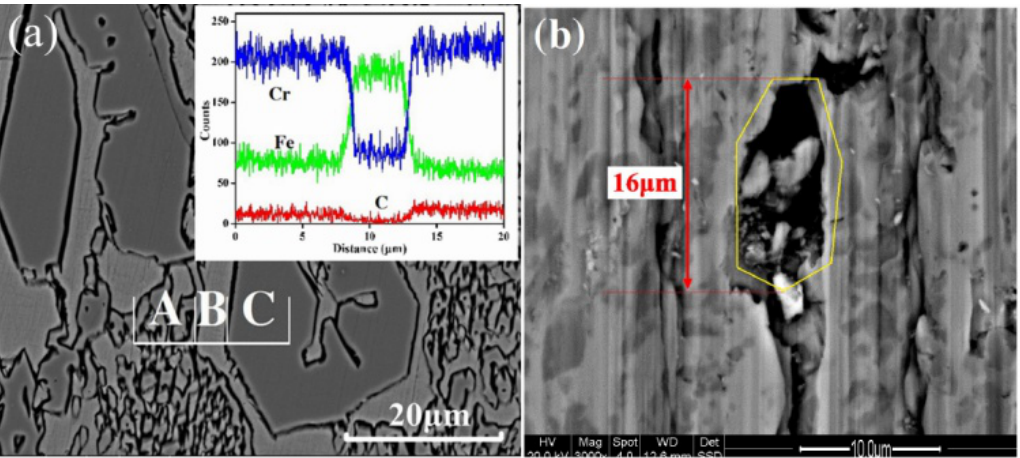
Figure 15. Morphology of the primary carbide in 3.6C-20Cr-Fe HCCI hardfacing layer, ( a ) before wear, ( b ) after wear.